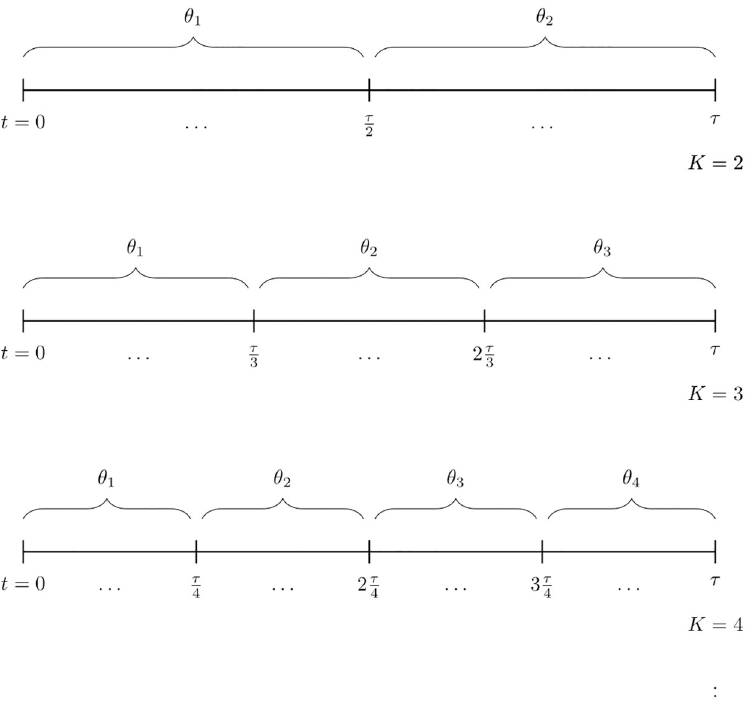
Fig 2. Illustration of the procedure behind the Bayesian test for time-varying network effects in relational event history data. The observed relational event history is divided into K sub-sequences that are evenly spaced in time. For each sub-sequence k = 1, ... , K the vector of model parameters θ is estimated. The statistical evidence in the data for k H static : θ 1 = ��� = θ K versus H dynamic : not H static is evaluated by means of the BF.